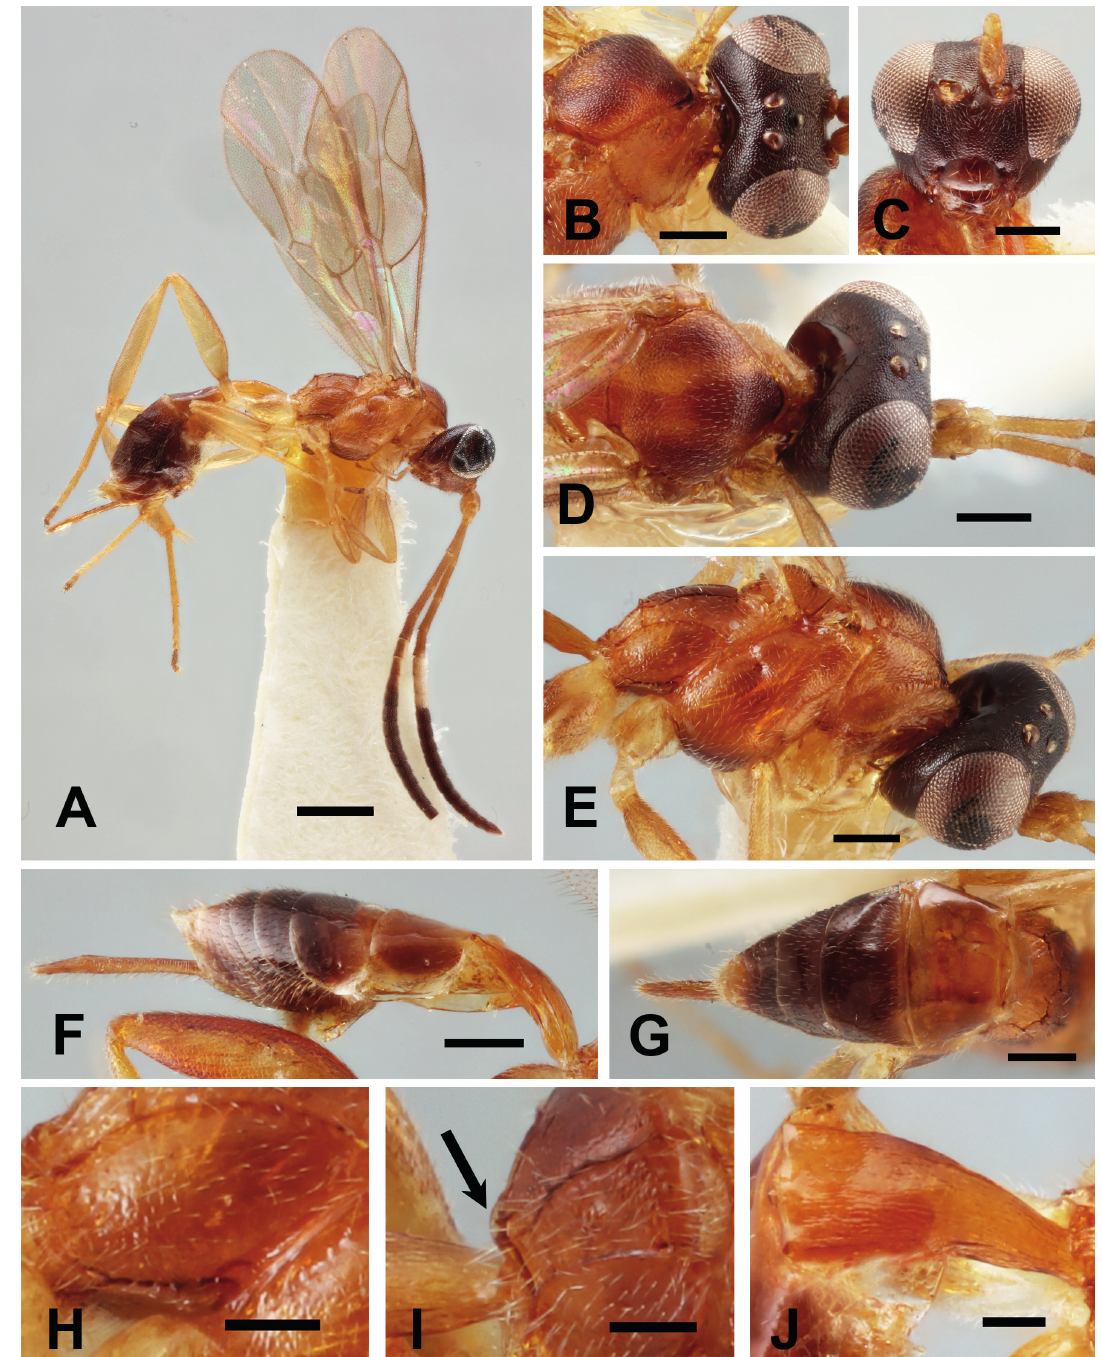
Fig. 5. Morphology of Handaoia plaumanni sp. nov. A . Habitus, lateral view, holotype, ♀ (NHMUK010636386). B . Head, dorsal view, paratype, ♀ (NHMUK010636395). C . Head, front view, paratype, ♀ (NHMUK010636382). D . Mesoscutum, dorsal view, paratype, ♀ (NHMUK010636395). E . Head and mesosoma, lateral view, paratype, ♀ (NHMUK010636395). F . Metasoma, lateral view, paratype, ♀ (NHMUK010636382). G . Metasoma, dorsal view, paratype, ♀ (NHMUK010636382). H . Metapleuron, paratype, ♀ (NHMUK010636395). I . Propodeum, paratype, ♀ (NHMUK010636382) (arrow: propodeal apophysis). J . Tergite I, dorsal view, paratype, ♀ (NHMUK010636382). Scale bars: A = 0.5 mm; B–G = 0.2 mm; H–J = 0.1